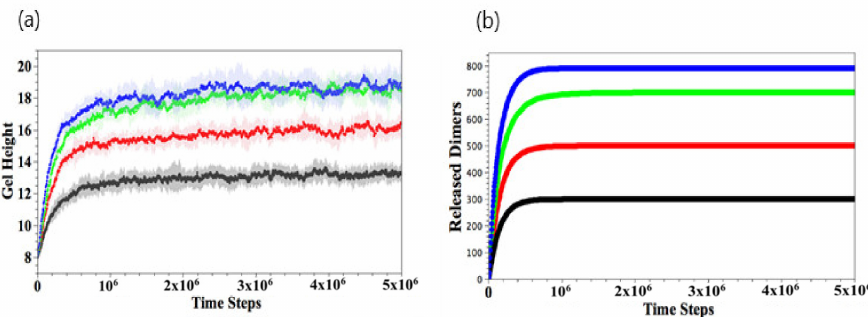
Figure 7. Temporal evolution of gel height ( a ) and number of released dimers ( b ) N EDTA = 300 (black), 500 (red), 700 (green), and 900 (blue), respectively. The error bars in ( b ) are within the width of the lines marking the